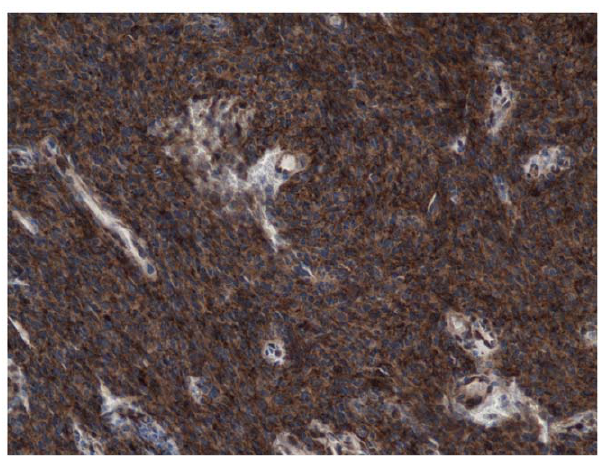
Figure 2. Immunohistochemical analysis, example of a patient with PTEN retained.